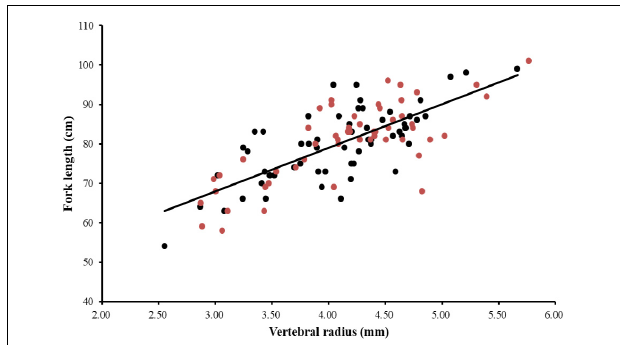
FIGURE 7 | Relationship between the fork length (cm) and the centrum radius (mm) for the combined sexes of P. kamoharai specimens from the TEA Ocean ( n = 114). Red dots represent observations of female specimens and black dots, male specimens while the solid line represents the linear regression equation F L = 11.12 R + 34.54, r 2 = 0.55 for the combined sexes. F L = fork length and R = centrum radius.